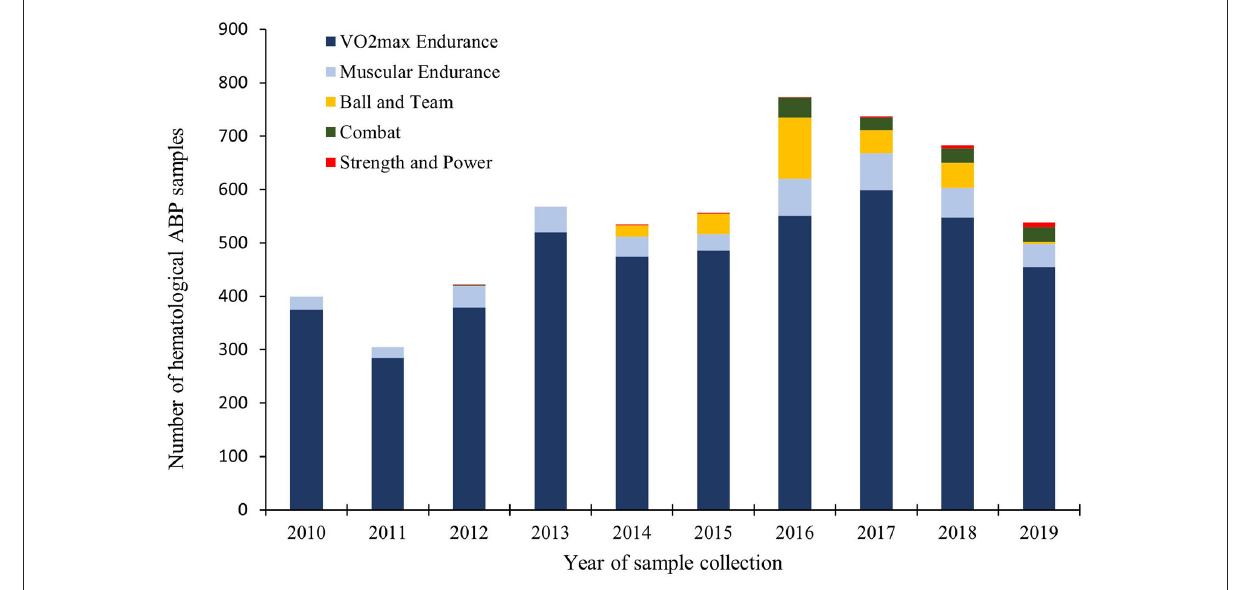
FIGURE1 Annually collected hematological ABP samples by physiological classification